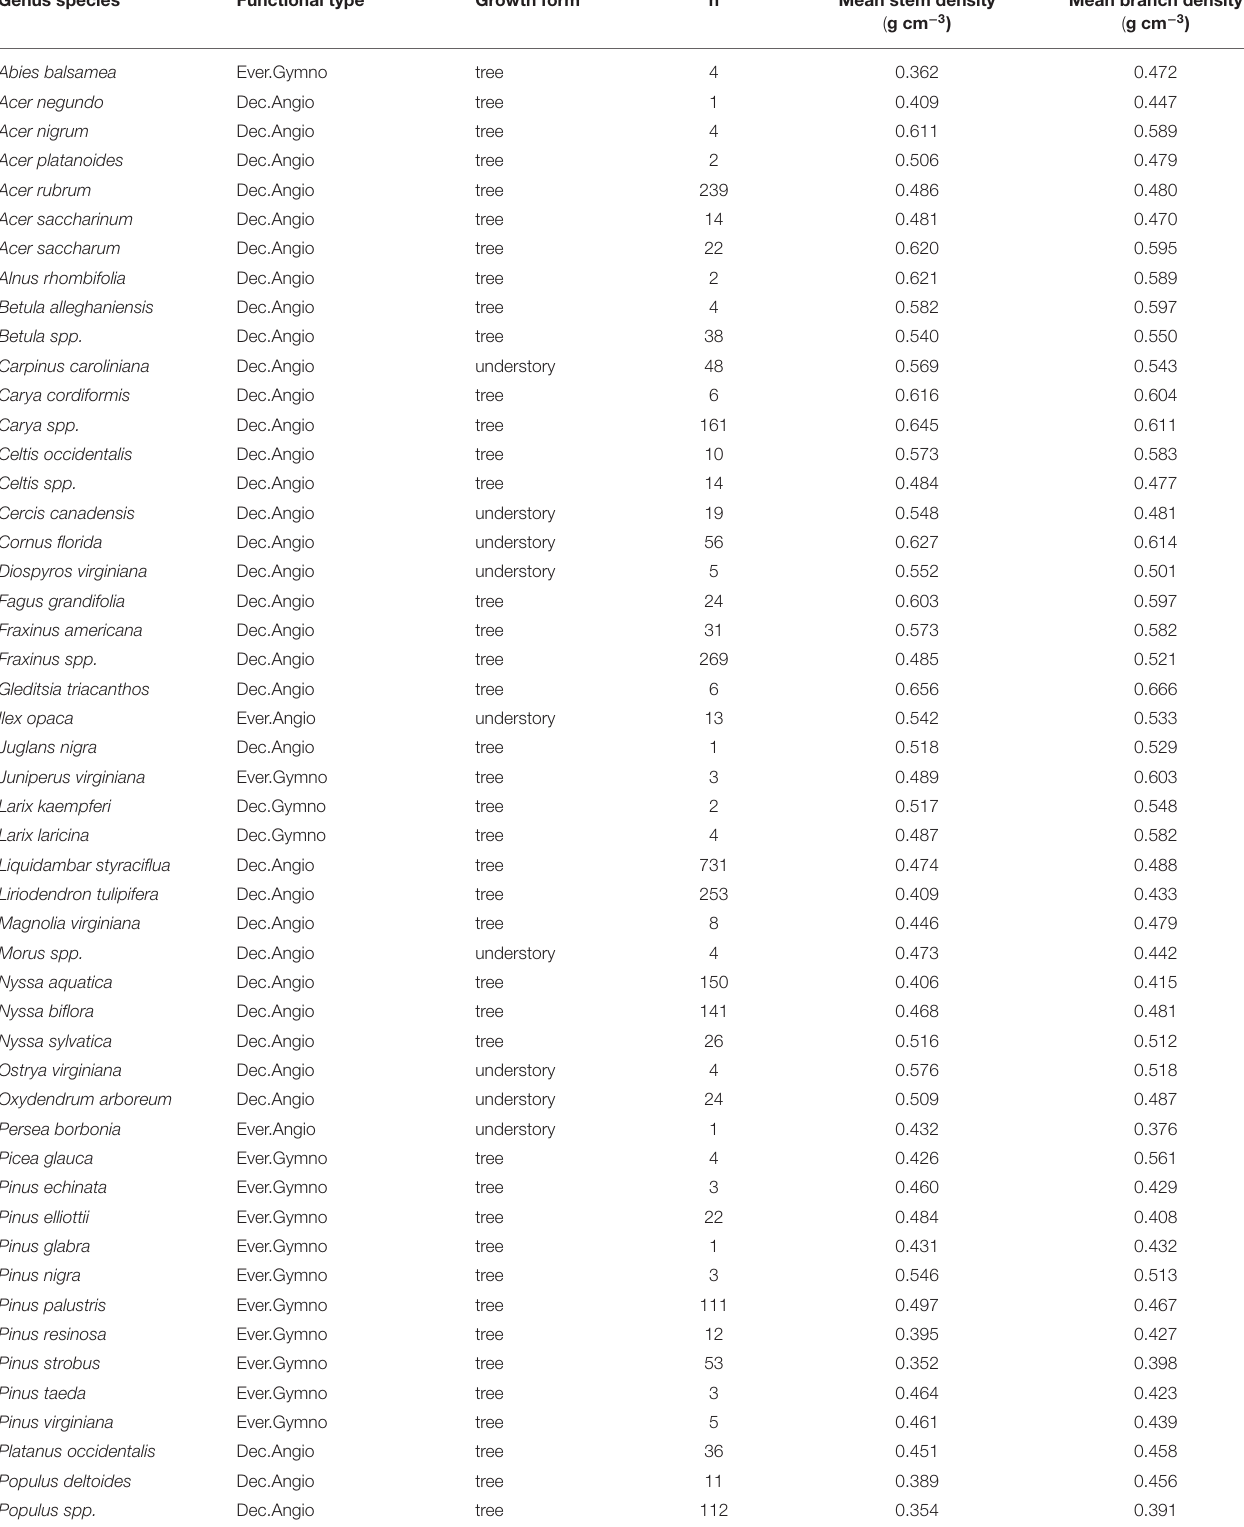
TABLE 2 | Number of sample trees by Genus spp. growth form and average stem and branch